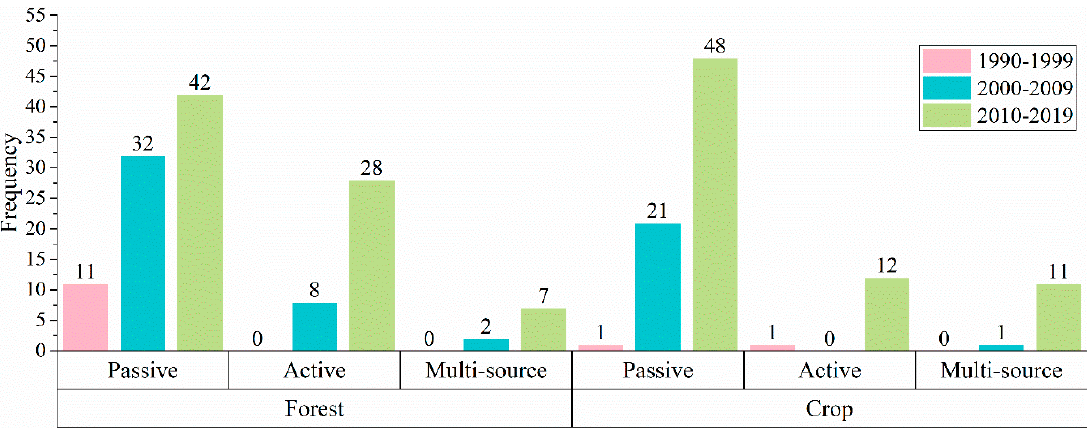
Figure 1. Temporal trends of the application of di ff erent detection systems for forest and crop LAI estimation from 1990–2019.